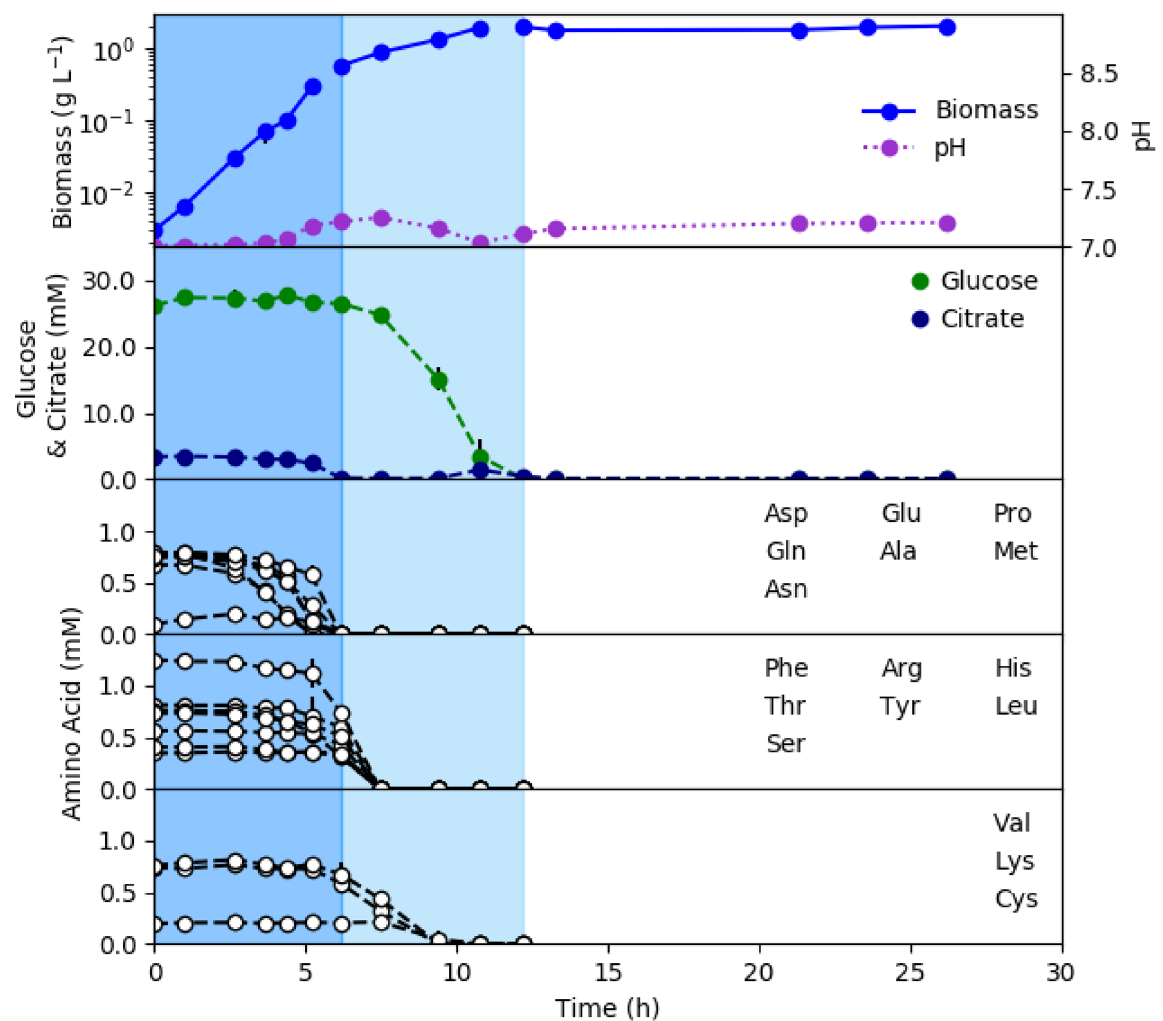
Figure 1. P. aeruginosa 215 was grown in chemically-defined, glucose containing, medium (CSP G) in batch culture. Cultures demonstrated two exponential growth phases highlighted with different background shading. Amino acids were binned into three categories based on their time of exhaustion. Top tier amino acids were consumed during the first exponential growth phase while lower tier amino acids and glucose were consumed during the second exponential growth phase. All values are averages of three biological replicates, and metabolite values are also averaged from two technical replicates. Additional data can be found in supplementary material